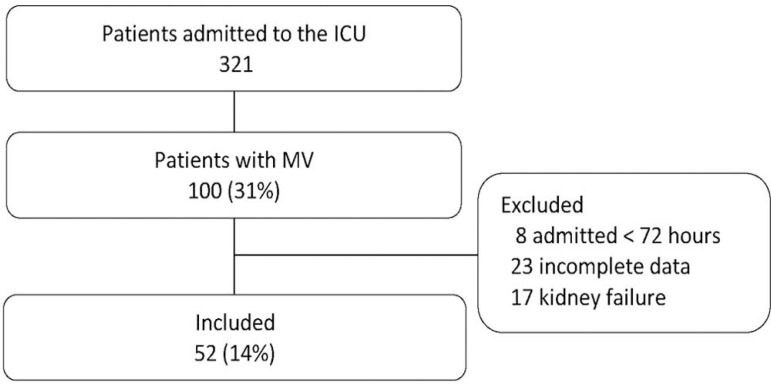
Flow chart of patient selection. ICU - intensive care unit, MV - mechanical ventilation.